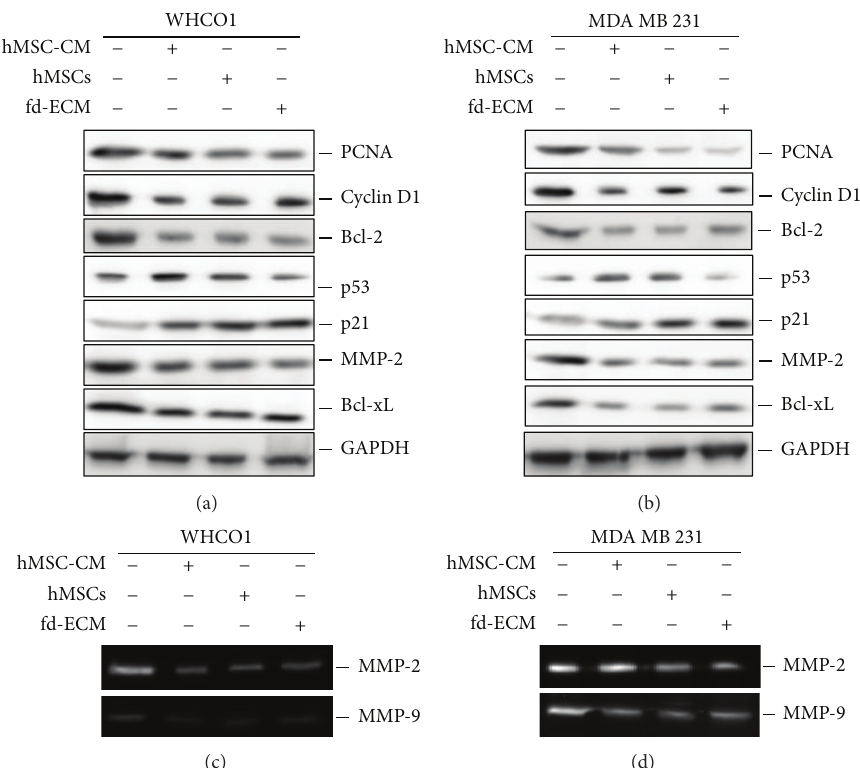
Figure 1: MSCs and fd-ECM inhibit cellular gene expression in WHCO1 and MDA MD 231 cells. (a) Western blot analysis of lysates from WHCO1 cells cocultured with MSCs or cultured on an fd-ECM for 24 hrs showing expression of PCNA, cyclin D1, Bcl-2, p53, p21, MMP-2, MMP-9, and Bcl-xL. (b) Western blot analysis of lysates from MDA MB 231 cells cocultured with MSCs or cultured on an fd-ECM for 24 hrs showing expression of the same genes as in (a). Glyceraldehyde 3-phosphate dehydrogenase (GAPDH) was used as a loading control. ((c)- (d)) MMP-2 and MMP-9 gelatinolytic activities in WHCO1 (c) and MDA MB 231 (d) in media samples after 24hrs of incubation at 37 ∘ C as described in Section 2. Gelatinolytic activity was observed as clear bands in the gels. Experiments were performed in triplicate and repeated at least 2